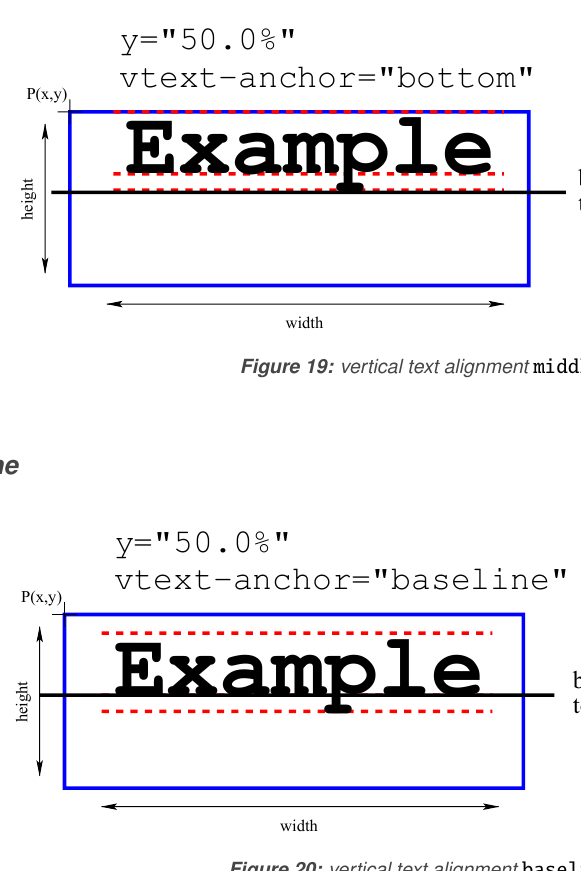
Figure 20: vertical text alignment